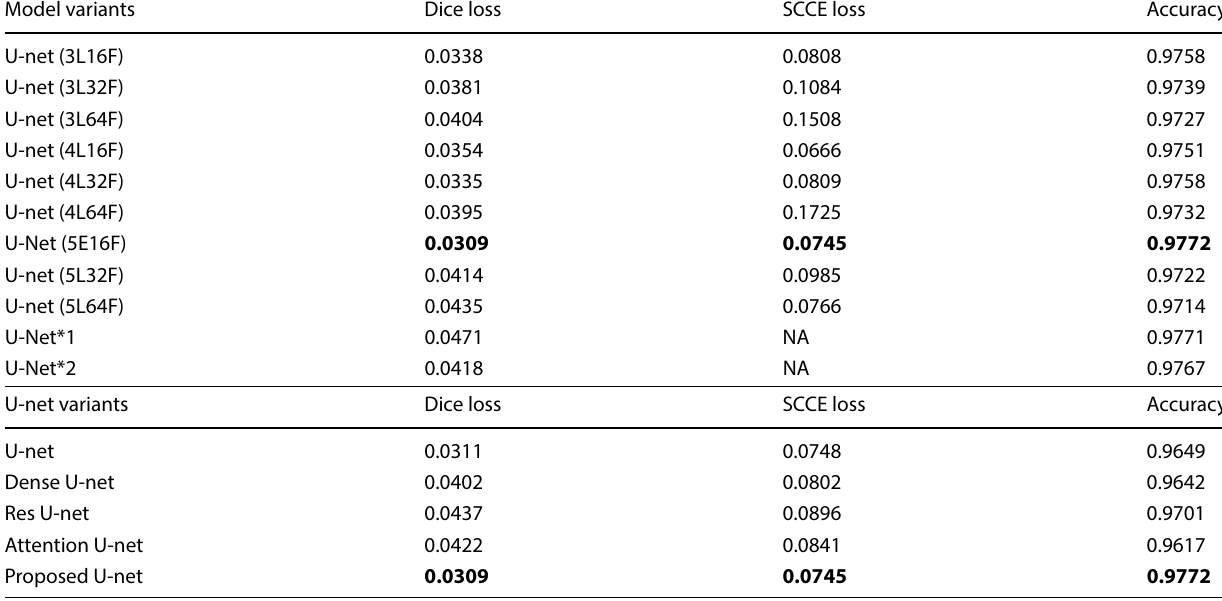
Table 4 Dice loss, sparse-cross-entropy loss and accuracy of U-Net models image segmentation for lungs on chest X-rays from testing data with different filter and encoding block hyperparameters